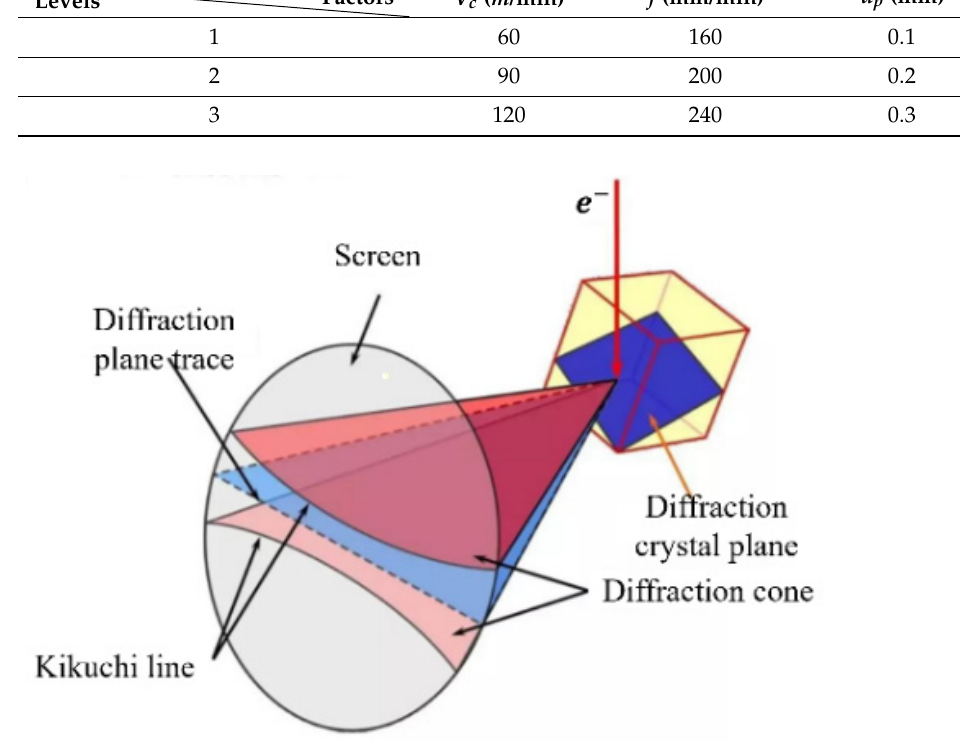
Figure 2. Schematic representation of the EBSD of single crystal planes.